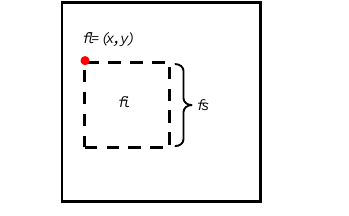
Fig. 2. The location fl , scale fs and feature type index fi of a Haar feature within a patch